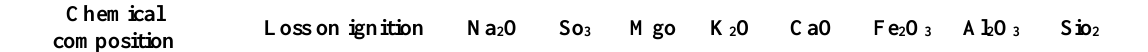
Table 3. Characteristics of the experimented cement (Type